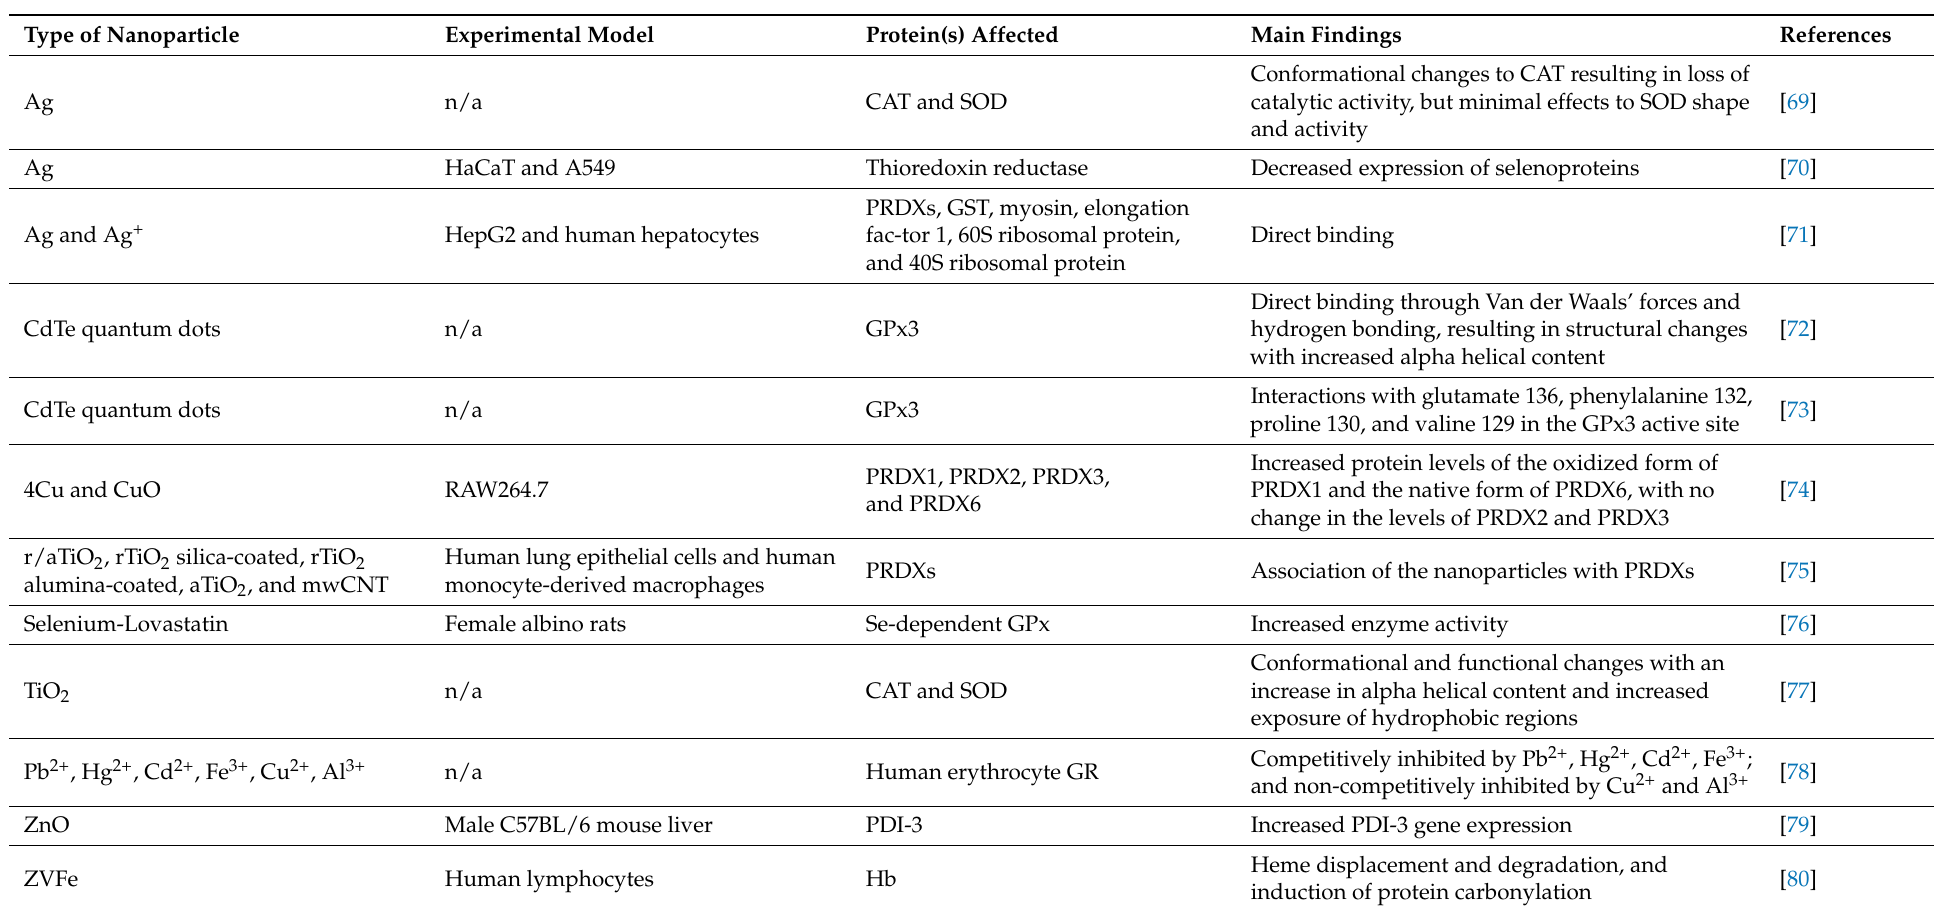
Table 2. Nanoparticle effects on oxidative stress and stress response